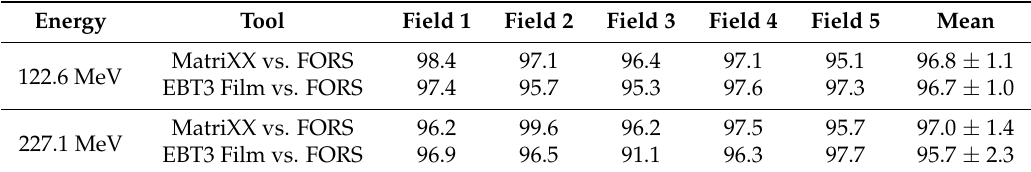
Table 2. Mean passing rates in gamma indices based on the gamma evaluation method for irregularly-shaped fields using MatriXX, EBT3 film, and FORS (units: